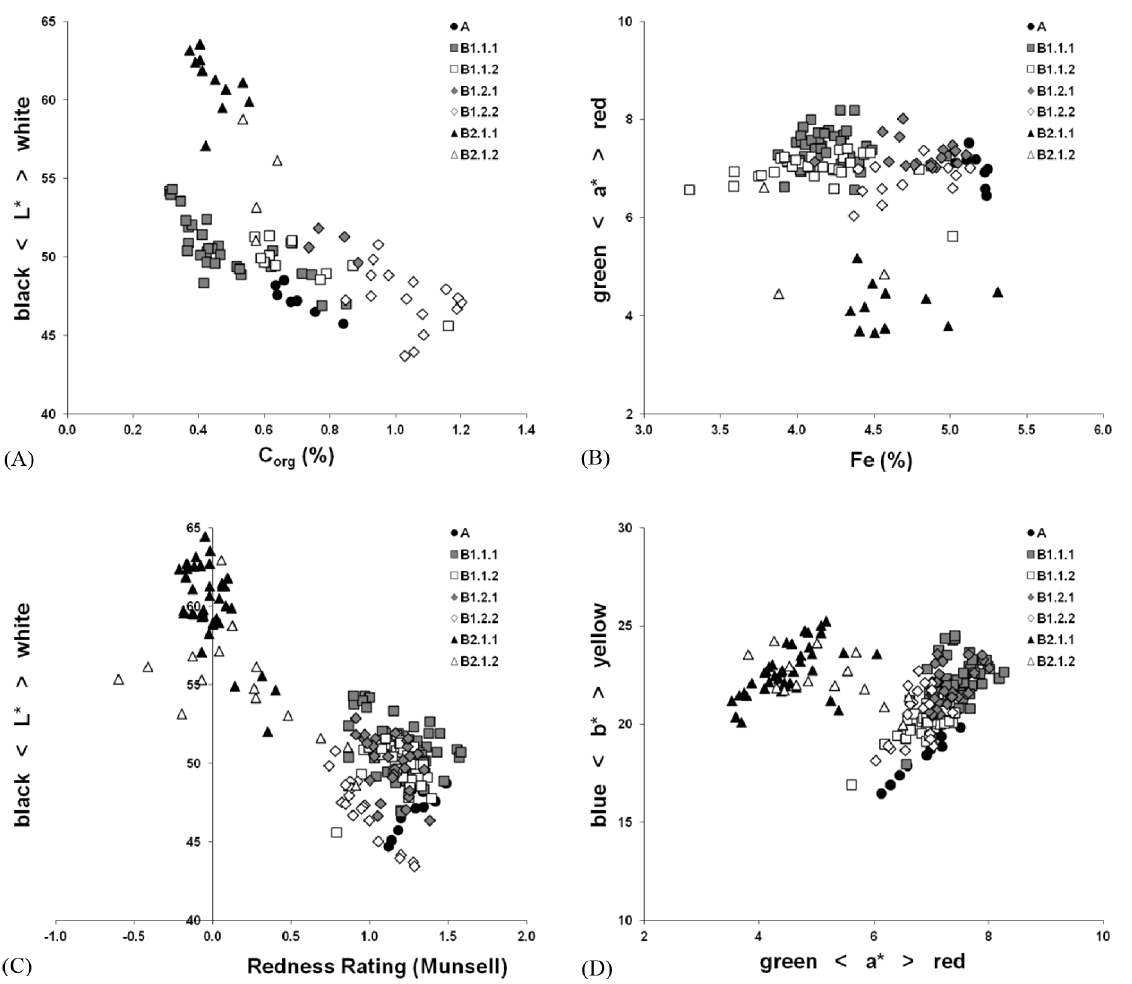
Figure 4. The colour values (CIE 1976) reflect the separation of the sediments into two main groups at 6.3mbd. The luminance ( L ∗ ) and the organic carbon concentrations (A) , and also the redness values ( a ∗ ) and the iron concentrations (B) , do not correlate. The redness rating (C) and the relation of yellowness to redness (D) indicate differences in Fe oxide composition and, most likely, the presence of hematite in the sediments above 6.3mbd, which includes the Holocene